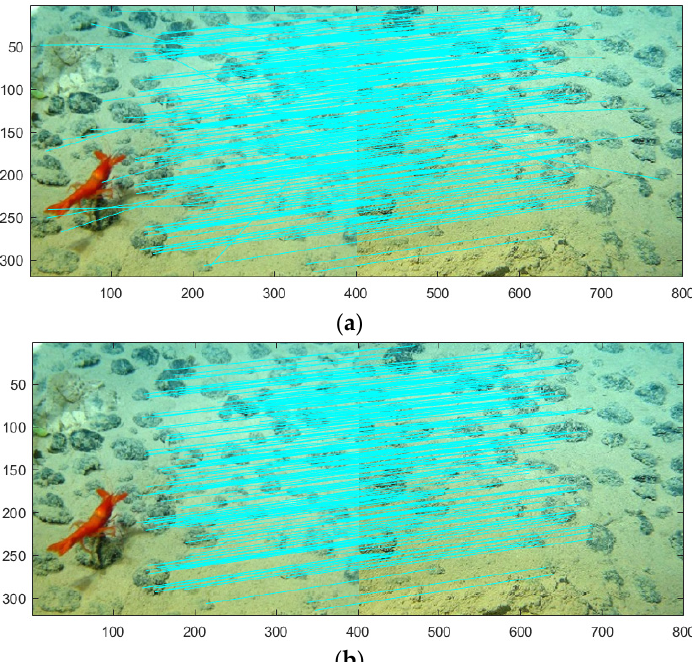
Figure 15. The registered images for T3: ( a ) I-RANSAC; ( b ) IIR. Using IIR algorithm, the number of matching points is less, and many mismatching points are eliminated.